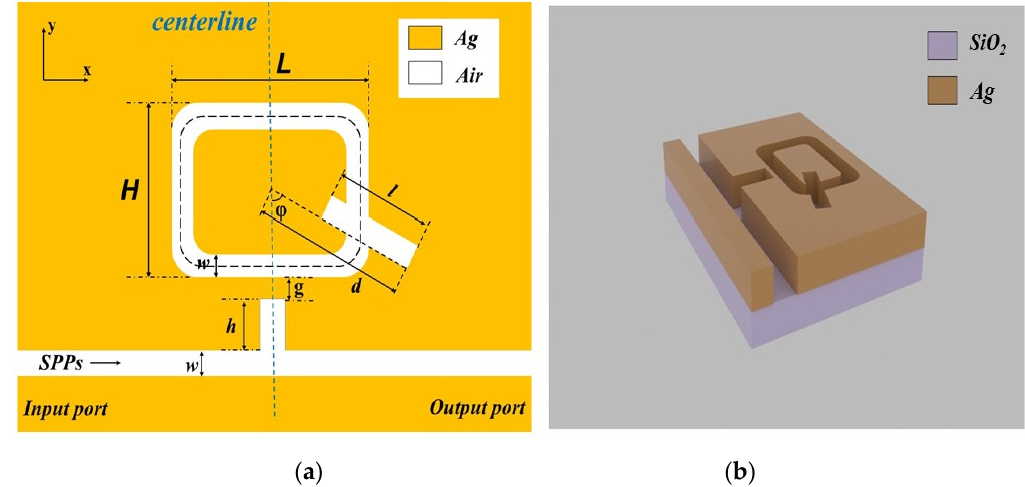
Figure 1. ( a ) 2D plan diagram of the structure; ( b ) 3D stereogram of the structure. The white and orange areas represent air and silver, respectively. Silver was chosen